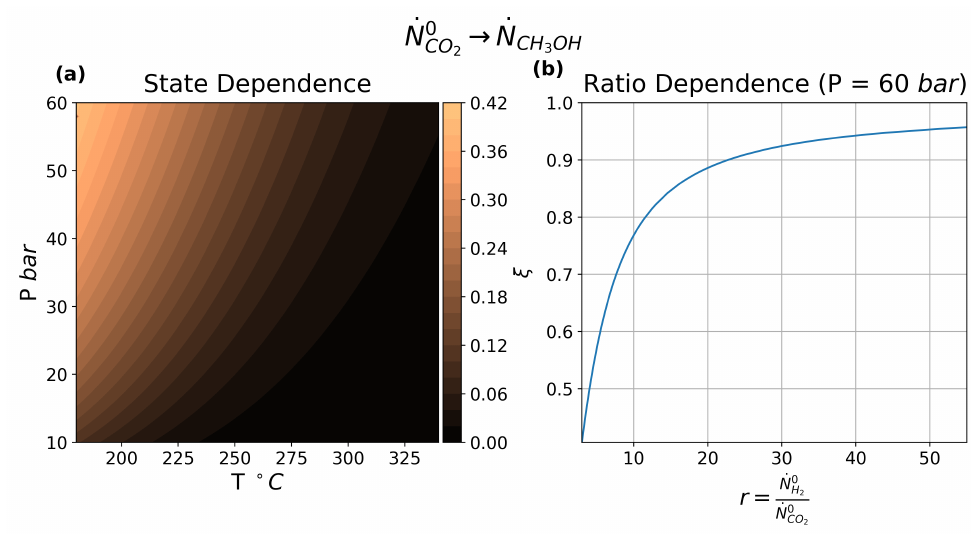
Figure 9. The conversion factor, ξ , or the percentage of moles of CO 2 transformed into CH 3 OH. It was calculated using the equilibrium equations presented in Terreni et al., 2020 [33], with varying state conditions ( P and T ) and molar ratios of H 2 and CO 2 . The state dependence curve was calculated with a H 2 /CO 2 molar ratio of 3, which is the stoichiometric ratio. Subplot ( a ) shows ξ ’s dependency on pressure and temperature. ( b ) shows ξ ’s dependency on the input ratio of H 2 and CO 2